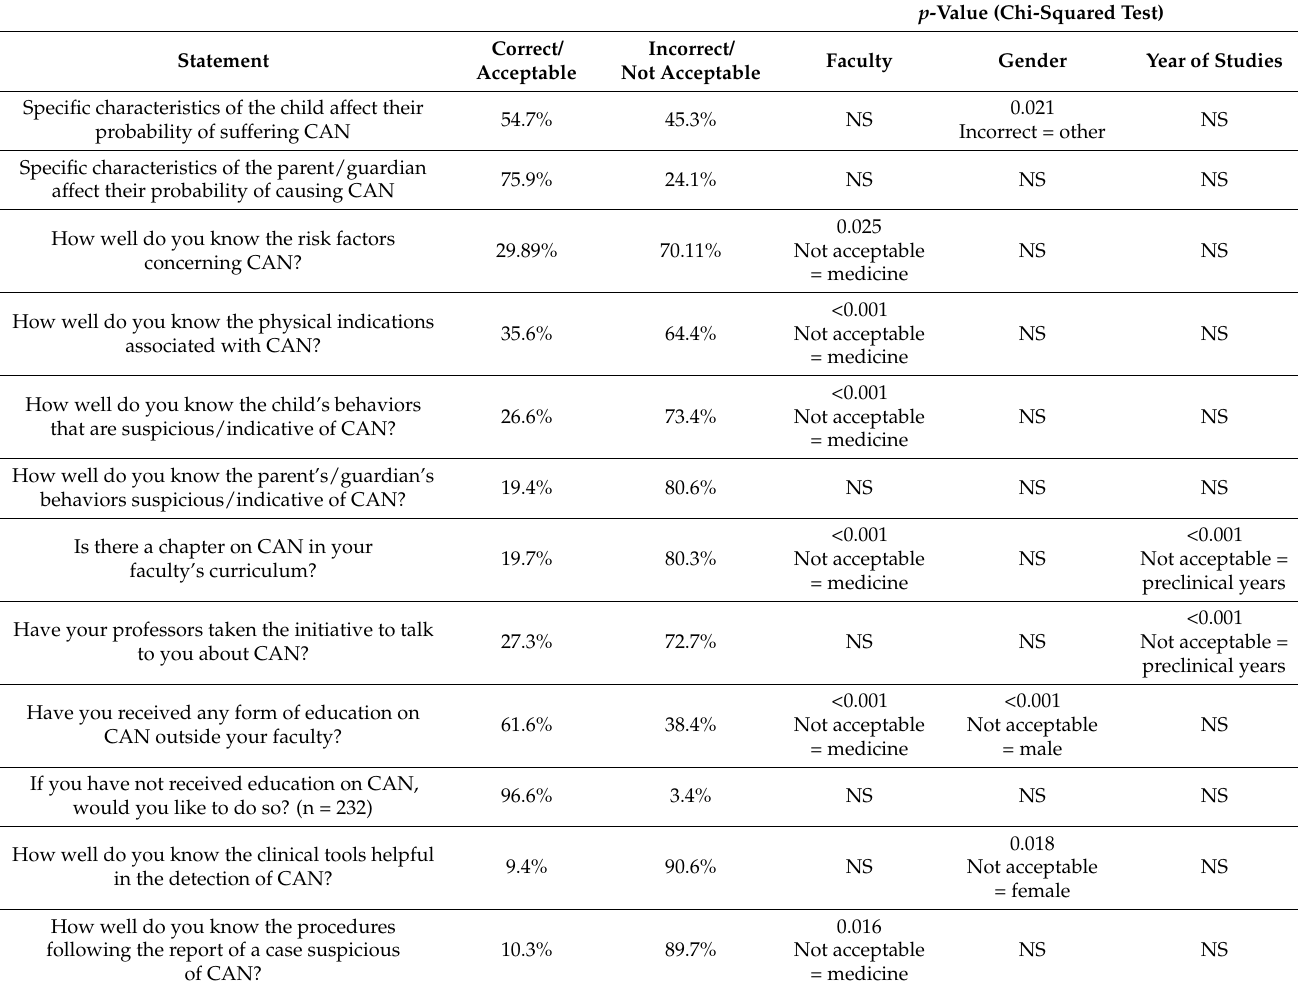
Table 4. Association of demographic characteristics with knowledge and attitudes regarding